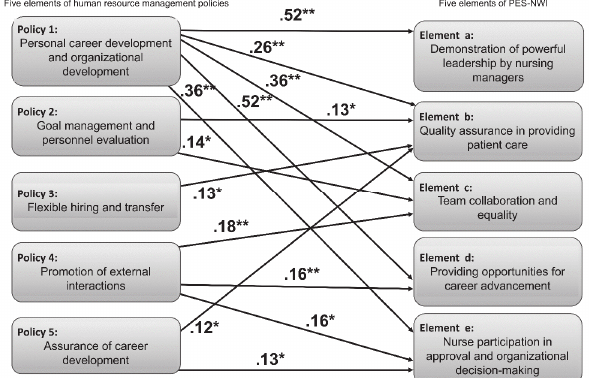
Fig. 1. Five elements of HRM policies and five elements of PES-NWI: Regression analysis of the elements. HRM = human resource management; PES-NWI = Practice Environment Scale of the Nurs- ing Work